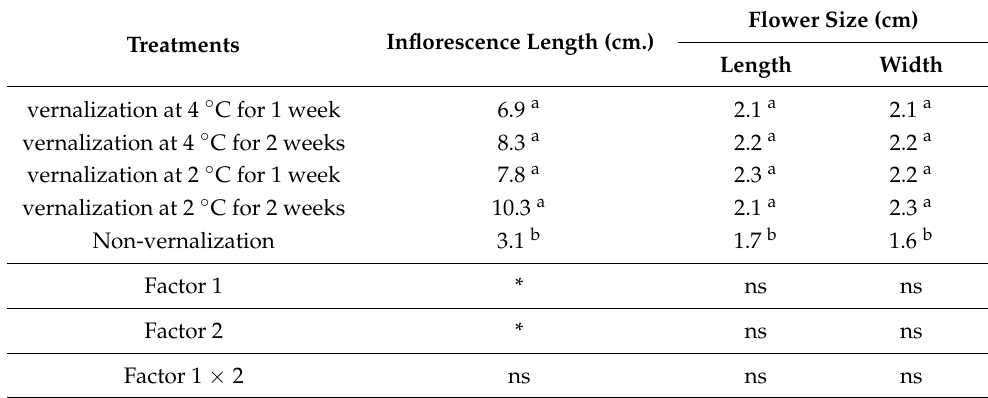
Table 4. Effects of vernalization on inflorescence length and flower size in strawberry cv. Pharachatan 80.